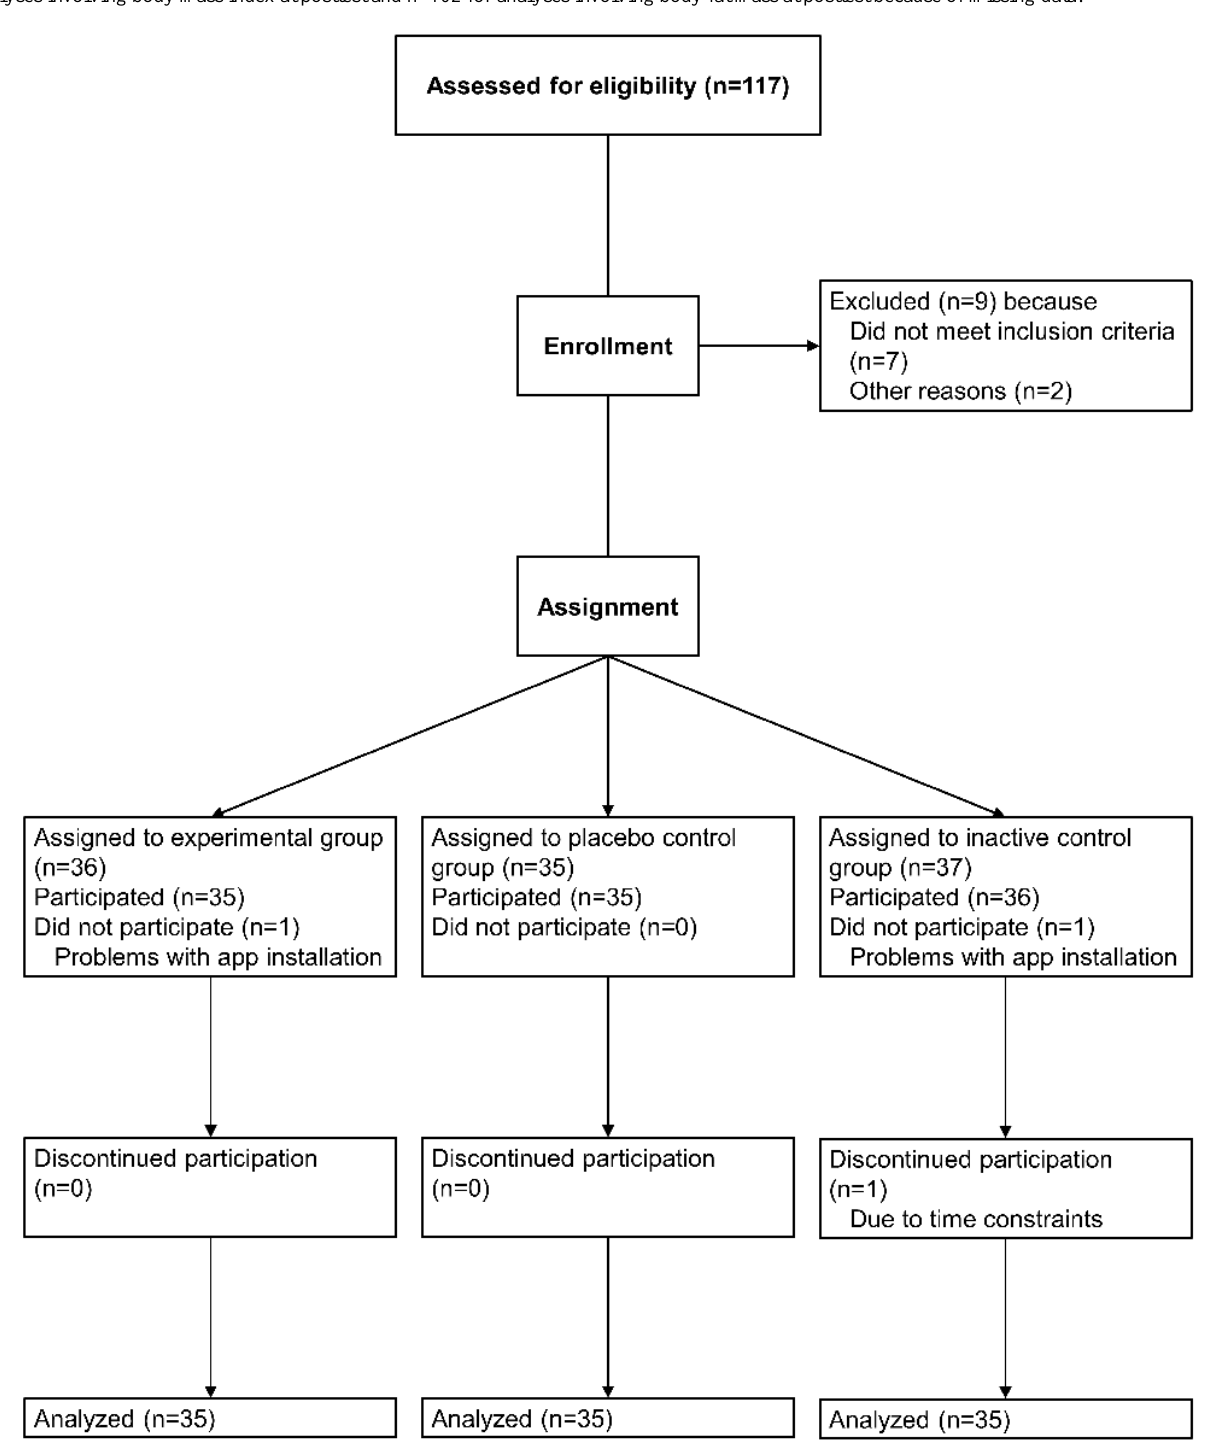
Figure 1. Flow of participants throughout the study. Note that while sample size was n=105 for the majority of analyses, sample size was n=104 for analyses involving body mass index at posttest and n=102 for analyses involving body fat mass at posttest because of missing